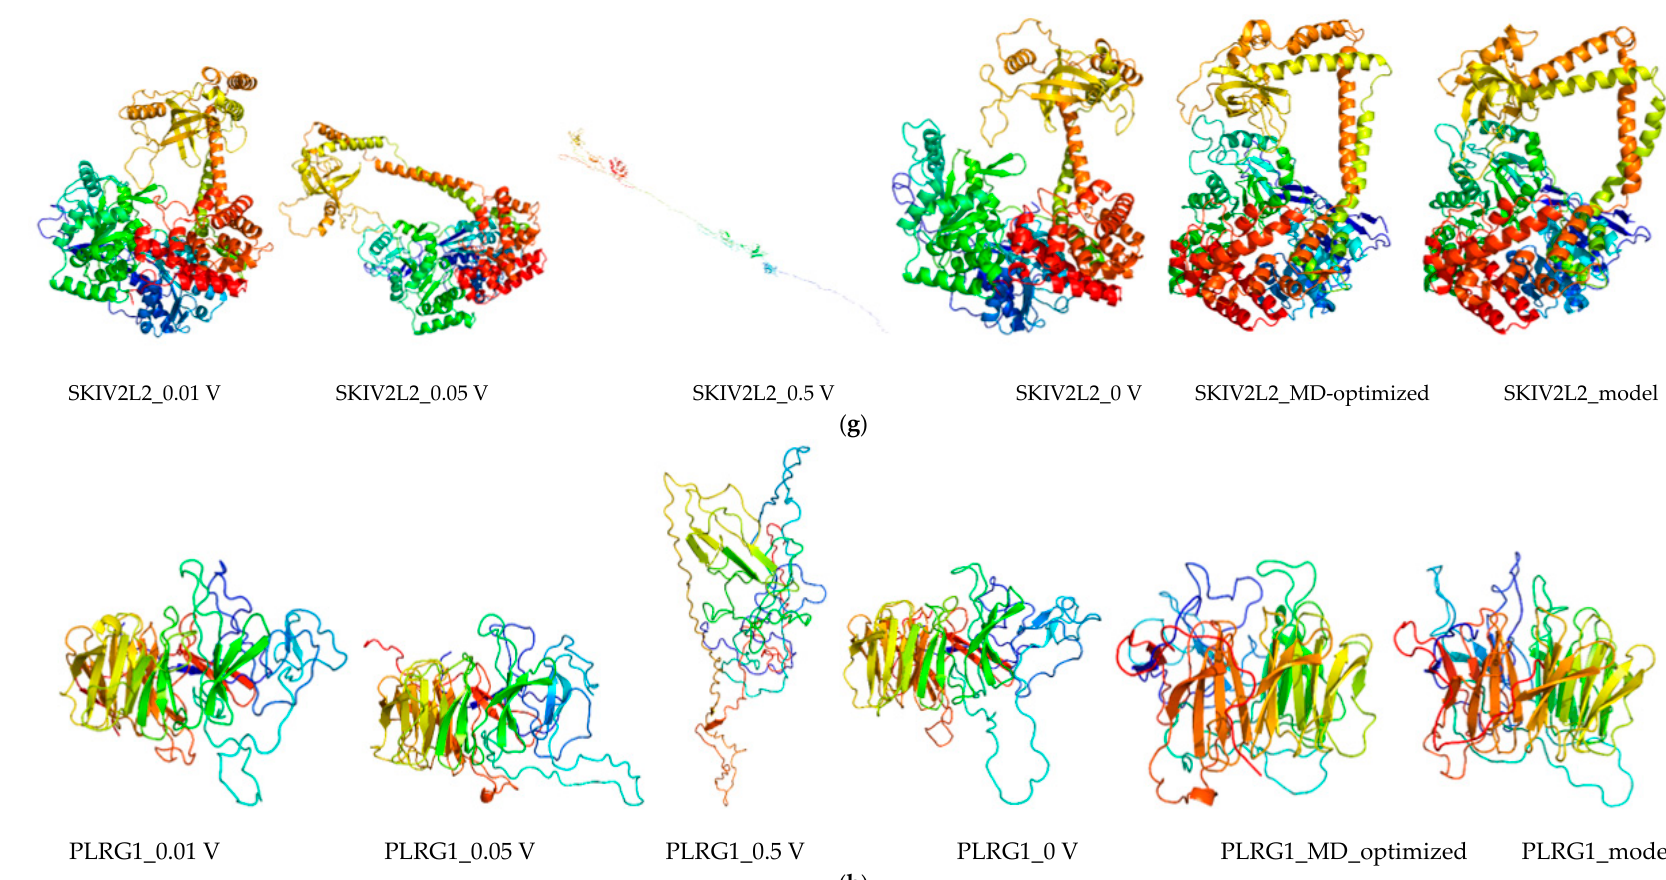
Figure 8. The structure of the 3D protein of hub proteins optimized by molecular dynamics. ( a ) SUGP1_model: the three-dimensional structure of the SUGP1 protein obtained by modeling; SUGP1_MD-optimized: after at least 100 ns molecular dynamics simulation, the lowest energy protein conformation of SUPG1 protein was obtained (based on the three-dimensional structure of the primary modeling) and was subsequently used for subsequent molecular dynamics simulations. After simulation of di ff erent electric field conditions, including 0 V (SUGP1_0 V), 0.01 V (SUGP1_0.01 V), 0.05 V (SUGP1_0.05 V) and 0.5 V (SUGP1_0.5 V), the lowest energy protein of SUGP1 protein were obtained respectively. Other proteins ( b – h ) were treated similarly to the SUPG1 protein. The pictures were drawn by the Visual Molecular Dynamics (VMD) software and the color map of the protein structure was shown in terms of protein secondary